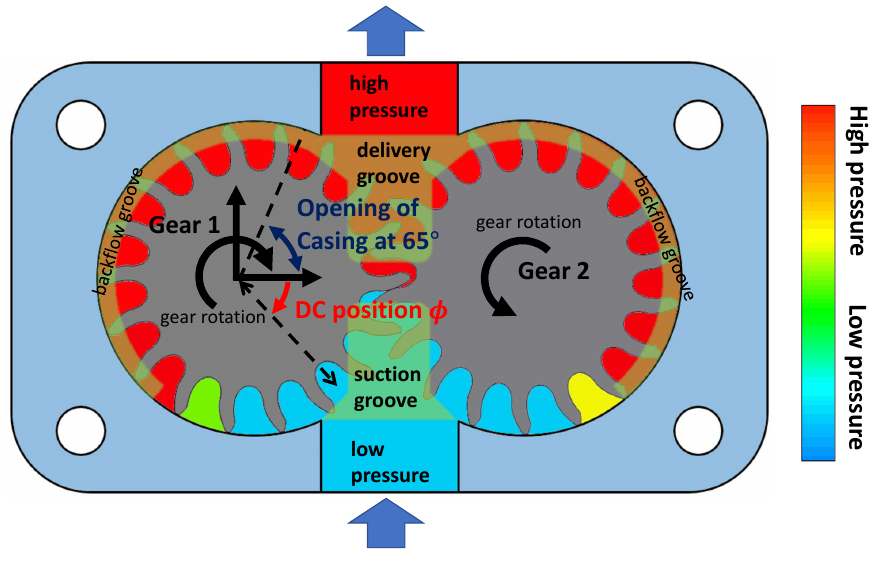
Figure 1. Cross sectional view of an EGP. The tooth space volumes are colored according to their pressure during a typical